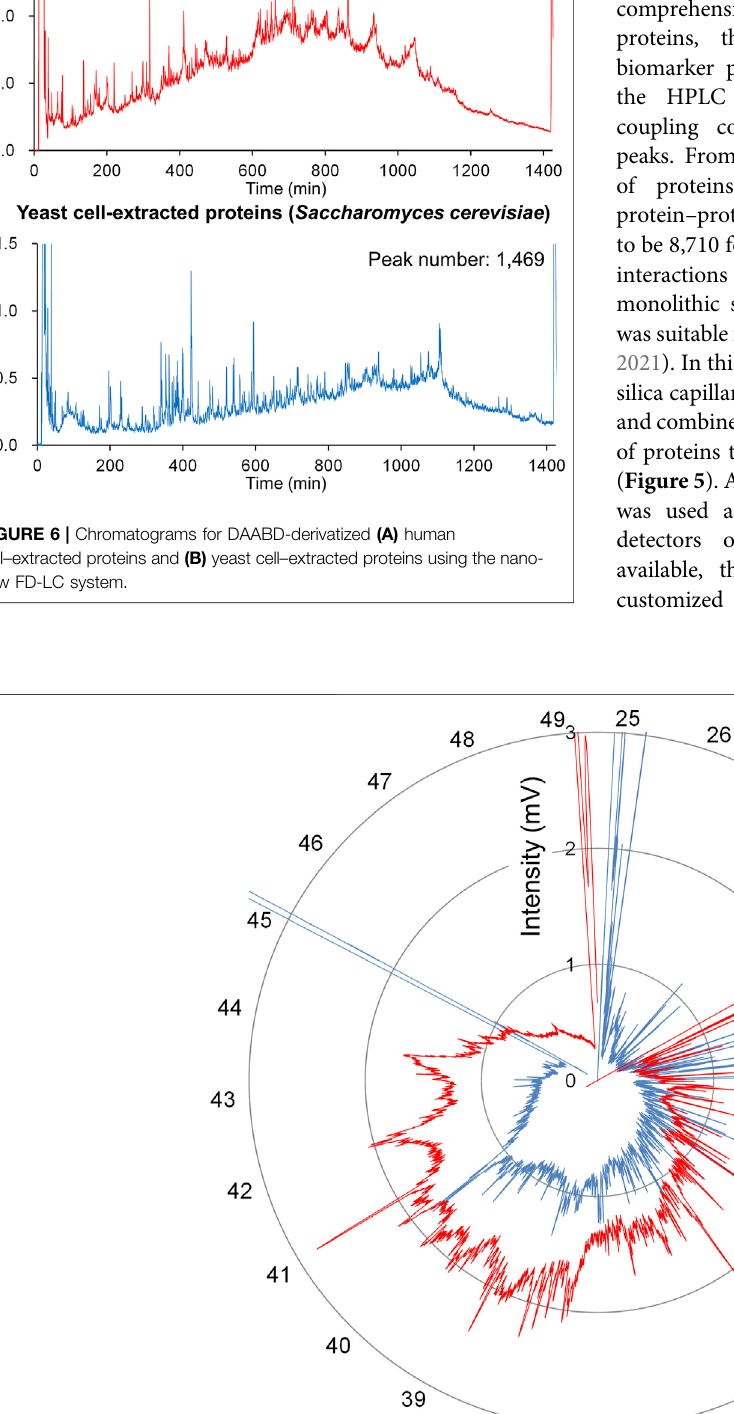
Frontiers in Chemistry |